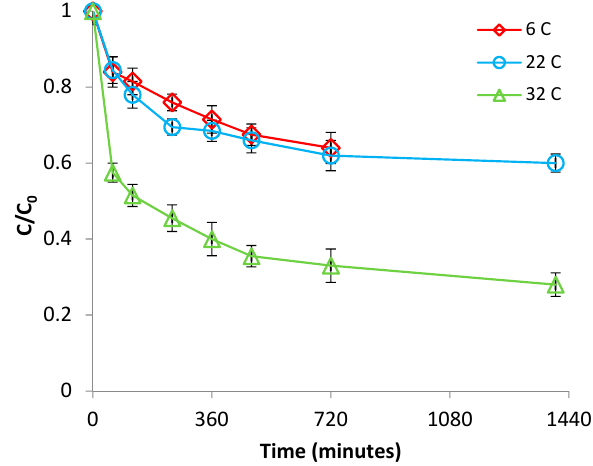
Figure 8. Effect of temperature on Cr(VI) removal by bentonite.